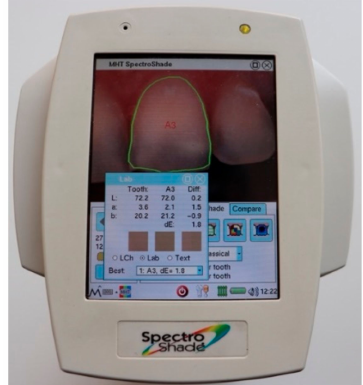
Figure 1. Defining the tooth area and the measurement of CIEL*a*b* values by the